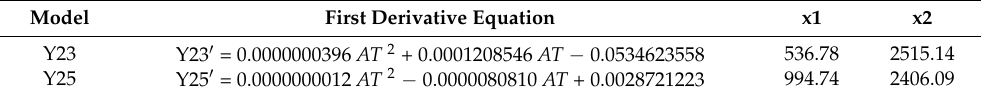
Table 4. The first derivative equation models of B mean and G skewness to accumulated temperature.